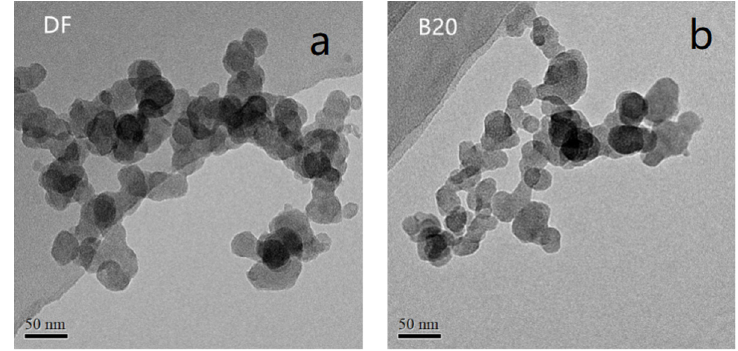
Figure 2. Typical TEM images of particles sampled at BMEP = 0.782 MPa: ( a ) DF, ( b ) B20 .